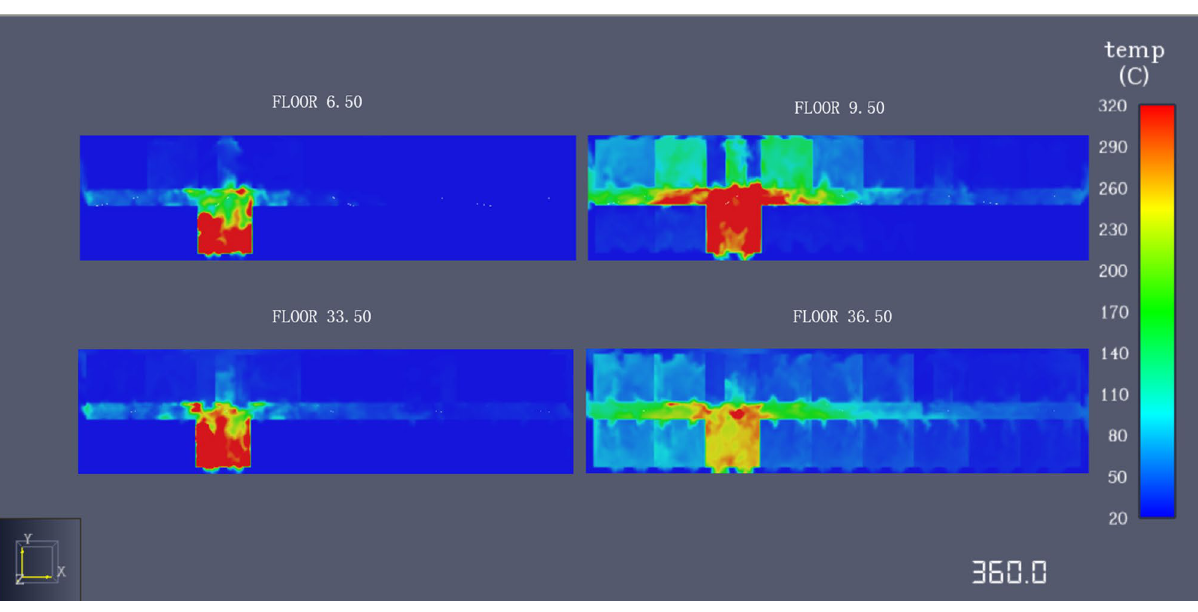
Figure 8. Slice diagram of temperature